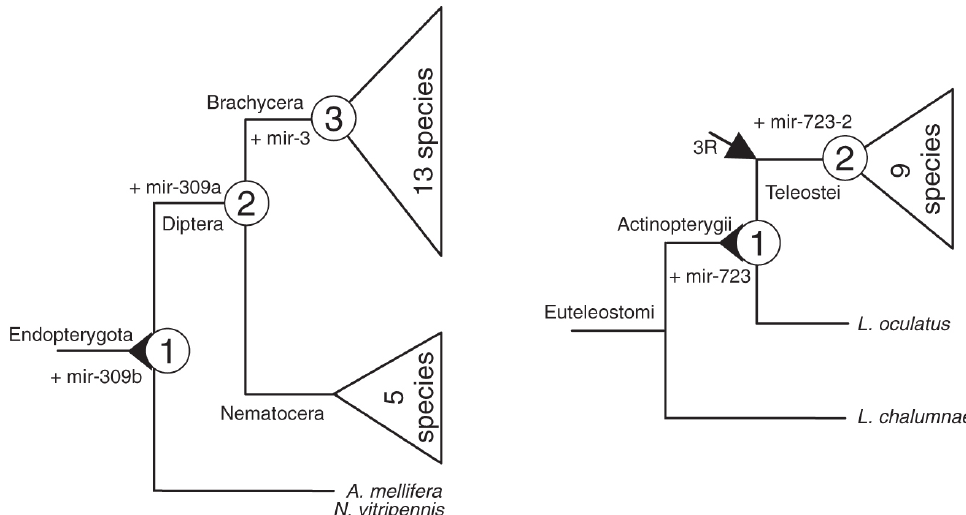
Figure 3: Distribution of miRNA homologs of miRNA families mir-3 (left) and mir-723 (right). Numbers at the nodes de- note potential observations of the number of paralogs. The black triangle assigns the LCA to the phylogenetic tree. ’ 3R ’ denotes the third round of whole genome duplication events that is assumed to have happened during the evolution of